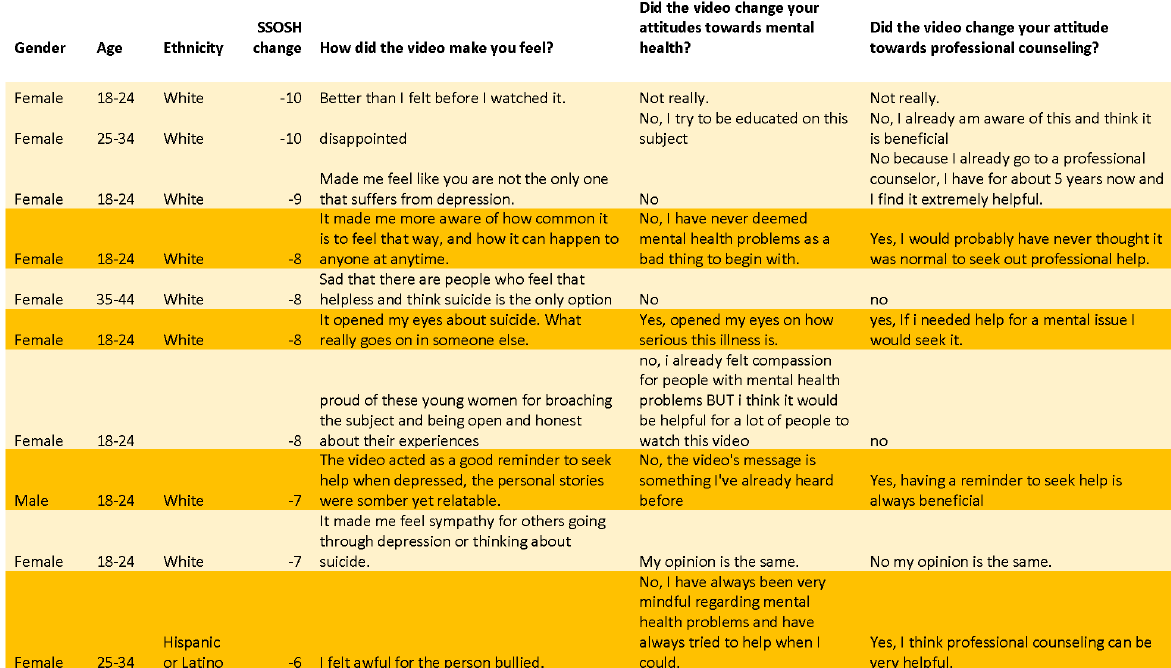
Figure 4. Group 1: large stigma reductions (respondents with stigma reductions > 3, i.e., a score change from − 4 to − 10). Participants were divided into two groups: those who reported increased openness to help-seeking (dark orange) and those who reported no change in attitudes towards counseling (light